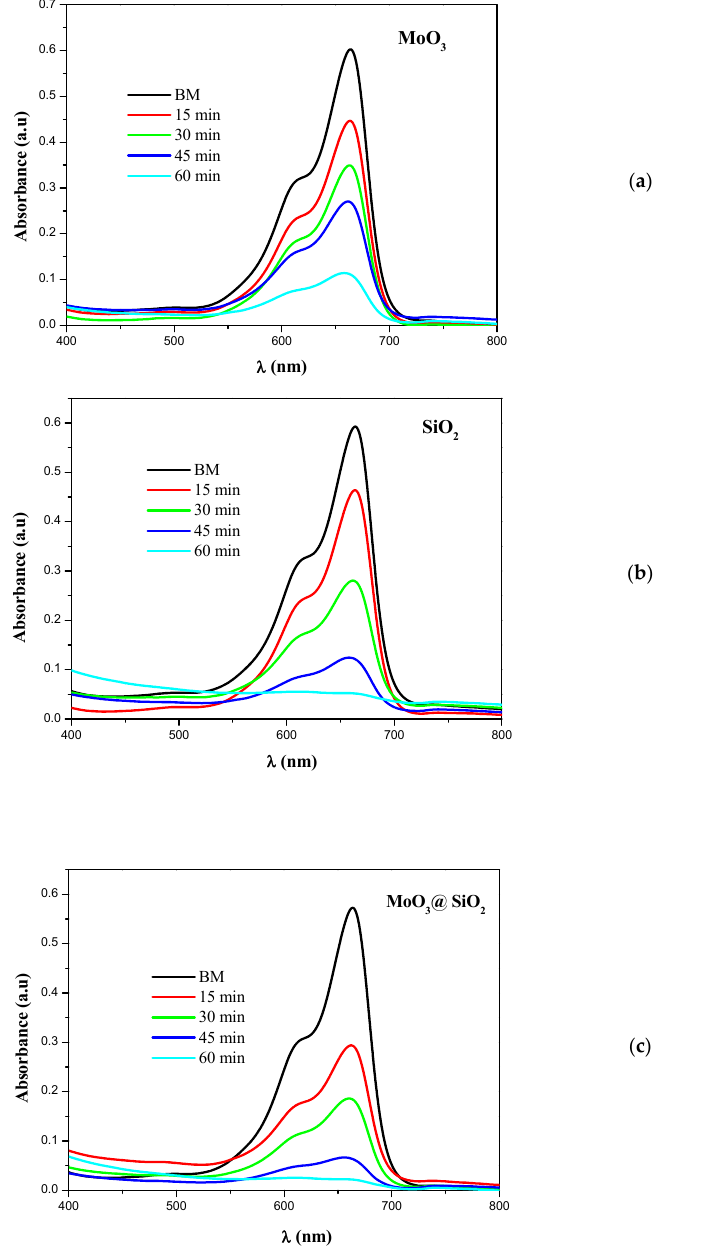
Figure 4. UV-Vis absorption spectra of MoO 3 nanoparticles ( a ), SiO 2 ( b ) and MoO 3 @ SiO 2 ( c ) .